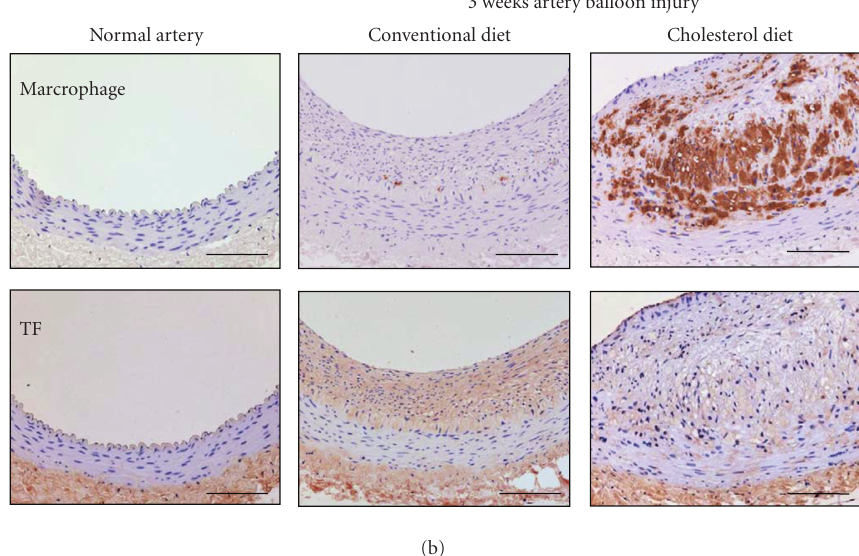
Figure 4: Angiographic and histological images of rabbit femoral arteries. (a) Representative angiographic and histological image 3 weeks after the balloon injury of left femoral artery. Injured femoral artery shows luminal narrowing and neointimal formation (N). Hematoxylin eosin/Victria blue stain (from Yamashita et al. [27] with permission). (b) Representative immunohistochemical microphotographs of normal and balloon-injured femoral arteries at 3 weeks after injury under conventional or 0.5% cholesterol diet. Tissue factor (TF) is expressed in neointimal smooth muscle cells (SMCs), macrophages, and adventitia. I, intima; M, media; Ad, adventitia. HE/VB, hematoxylin eosin/victoria blue